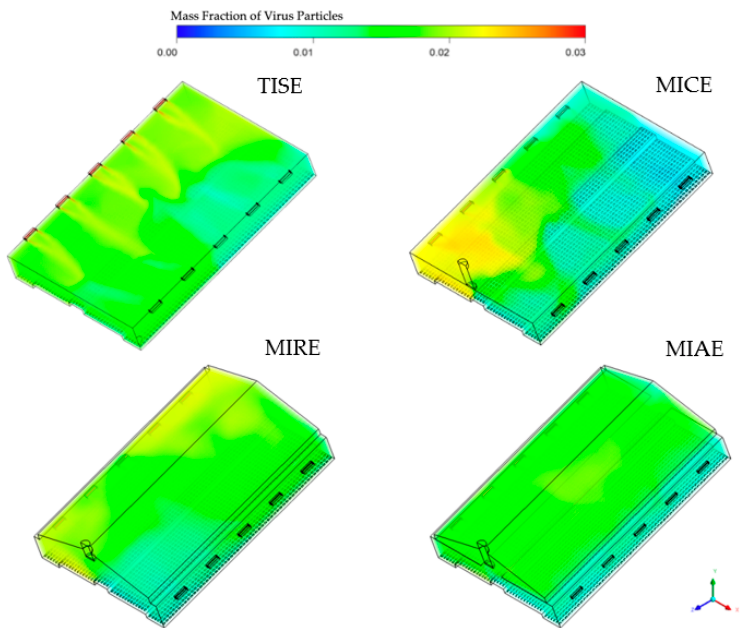
Figure 3. Three-dimensional illustration of four models representing ventilation schemes rendered with corresponding simulation results of indoor mass fractions of airborne viruses. Note that the transparency is inversely proportional to the magnitude of the mass fraction.